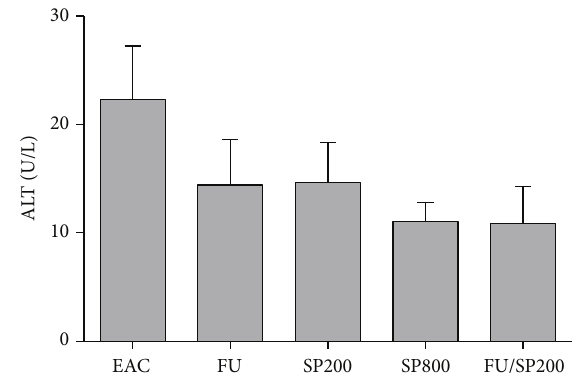
Figure 2: Effect of 5-fluorouracil (20mg/kg), spirulina (200 or 800 mg/kg), and their combination on ALT level of EAC tumor- bearing mice ( 𝑛 = 4 ). ALT: alanine transaminase; EAC: Ehrlich ascites carcinoma tumor-bearing mice; FU: Ehrlich ascites carci- noma tumor-bearing mice treated with 5-fluorouracil (20 mg/kg); SP200: Ehrlich ascites carcinoma tumor-bearing mice treated with spirulina (200 mg/kg); SP800: Ehrlich ascites carcinoma tumor- bearing mice treated with spirulina (800 mg/kg); FU/SP200: Ehrlich ascites carcinoma tumor-bearing mice treated with 5-fluorouracil (20 mg/kg) plus spirulina (200 mg/kg). Data are expressed as mean ± SEM. Statistical analysis using one-way ANOVA, followed by Dunnett’s